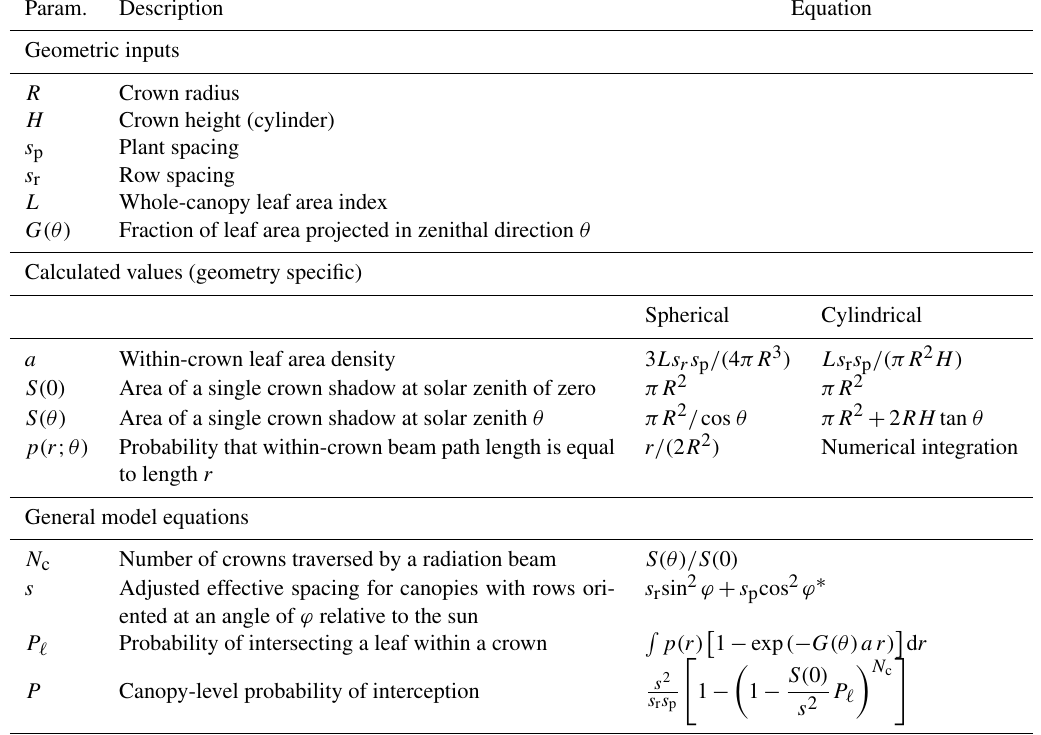
Table 2. Summary of 1-D models of radiation interception considered in this study. Model Equation Symbol Assumptions/notes BINOM Eq. (13) Red line Binomial distribution, variable crown path length, random or row arrangement Red circle Binomial distribution, constant crown path length, random arrangement (see Nilson, Poisson distribution, constant crown path length, random arrangement (see Nilson, Poisson distribution, variable crown path length, random arrangement (see Ni- Beer’s law with constant clumping factor (cid:127)( 0 ) Green triangle Beer’s law with empirical clumping factor model (see Campbell and Norman, 1998) Dotted